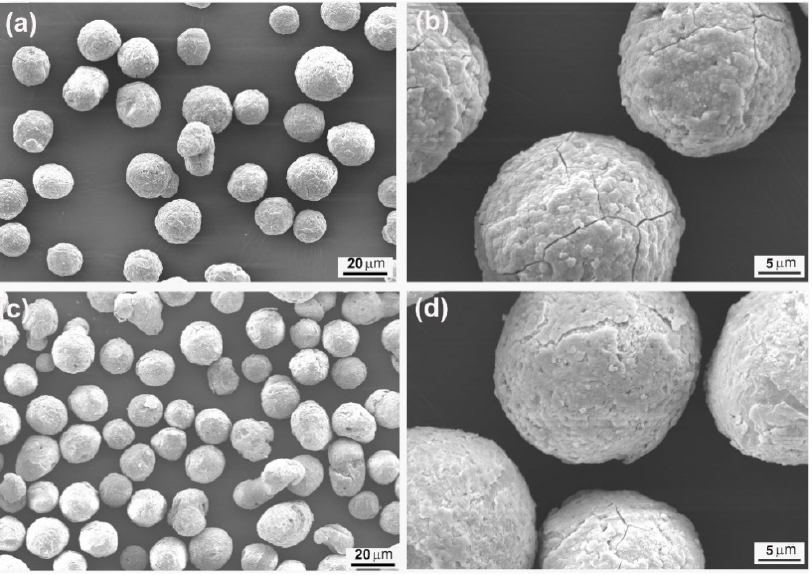
Figure 4. SEM images of SiO 2 -encapsulted SnZn 0.04 Cu 0.015 microspheres (encapsulation times = 3) before ( a , b ) and after calcination ( c , d ) at 400 °C in N 2 for 6 h.